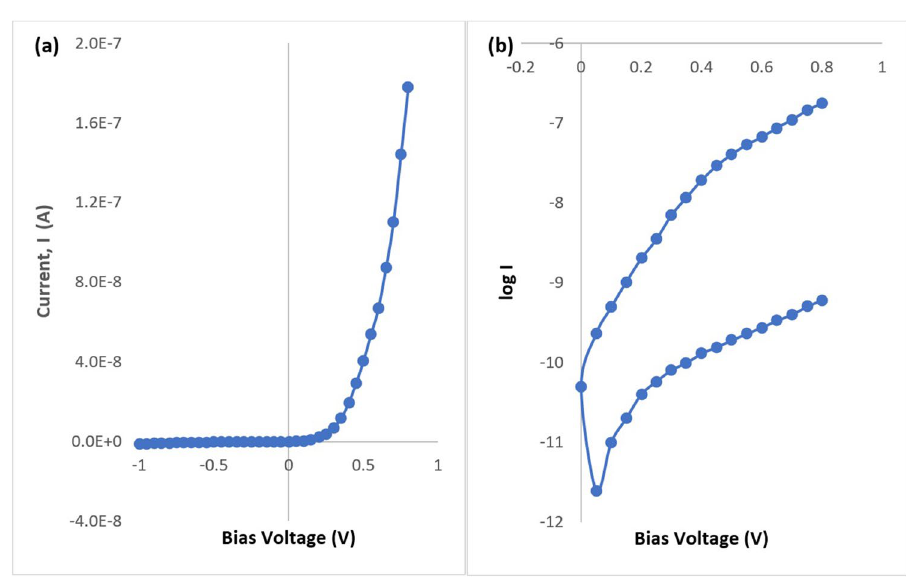
Figure 10. (a) Linear–linear I-V and (b) log-linear I-V characteristics of glass/FTO/p-CdMnTe/Al Schottky diodes under dark